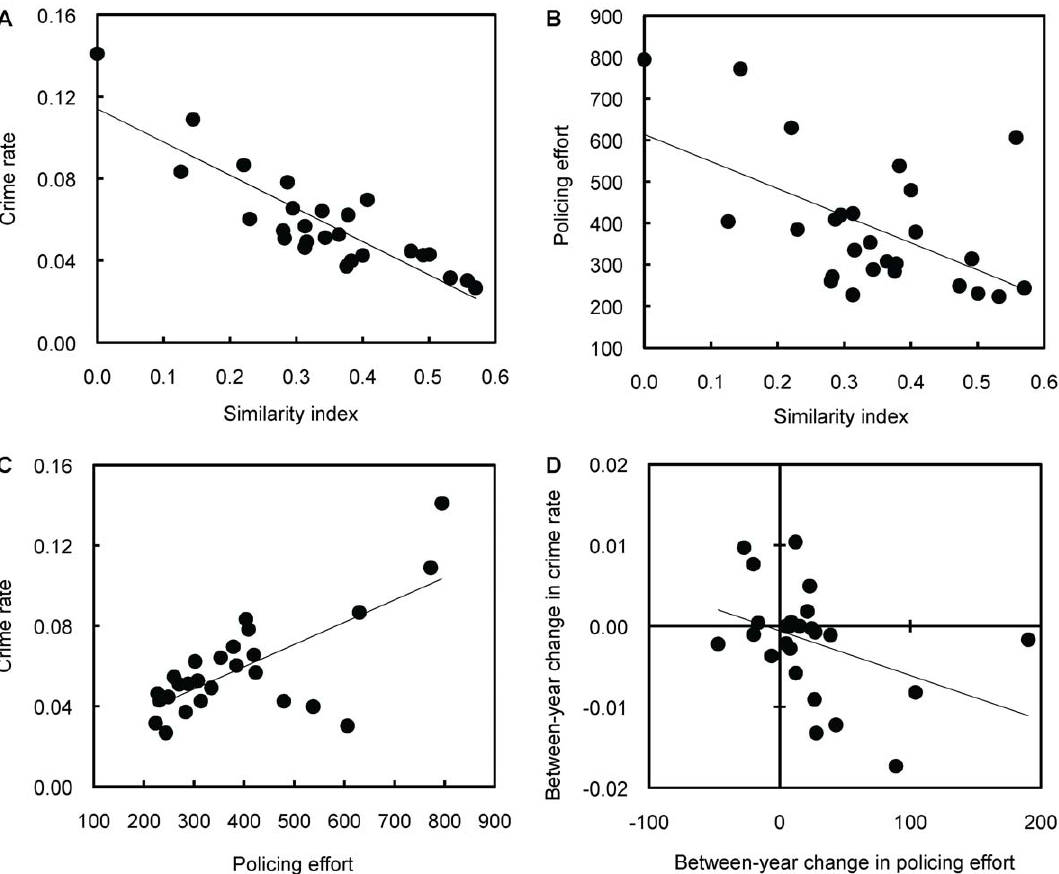
Figure 1. Testing predictions of evolutionary policing theory with data from human societies. Significant correlations (indicated by trend lines) between: (a) the per capita crime rate and the similarity index; (b) the policing effort (per capita investment into policing) and the similarity index; (c) the policing effort and the per capita crime rate; (d) the between-year change in policing effort and crime rate. Each data point represents one out of the 26 cantons of Switzerland.